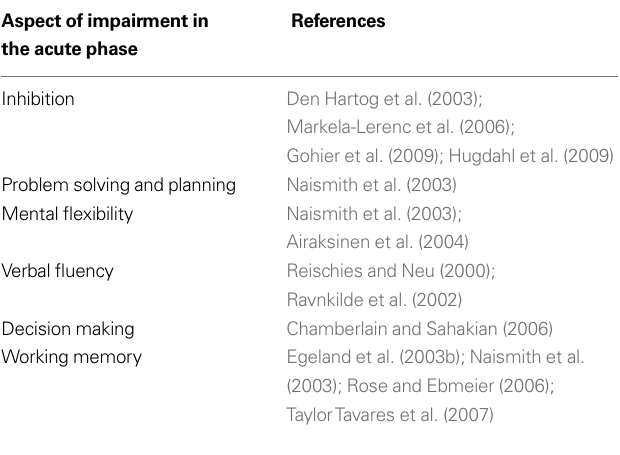
Table 1 | Findings of impairment within the cognitive domain of EF in the acute phase of